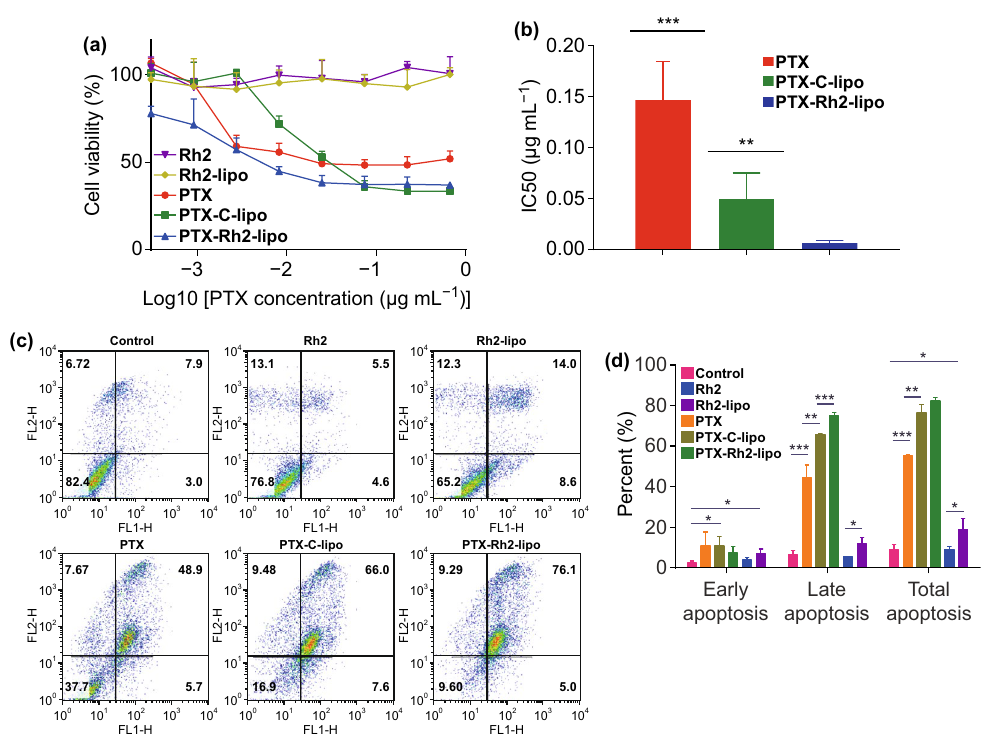
Fig. 5 a Cytotoxicity of different groups against 4T1 cells ( n = 4, mean ± SD). b IC 50 values of different PTX formulations. ** P < 0.01 and *** P < 0.001. c Representative scatter plots of Annexin V/PI analysis of 4T1 cells after drug treatments. d Percentage of cells with early, late, and complete apoptosis ( n = 3; mean ± SD). * P < 0.05, ** P < 0.01 and *** P <